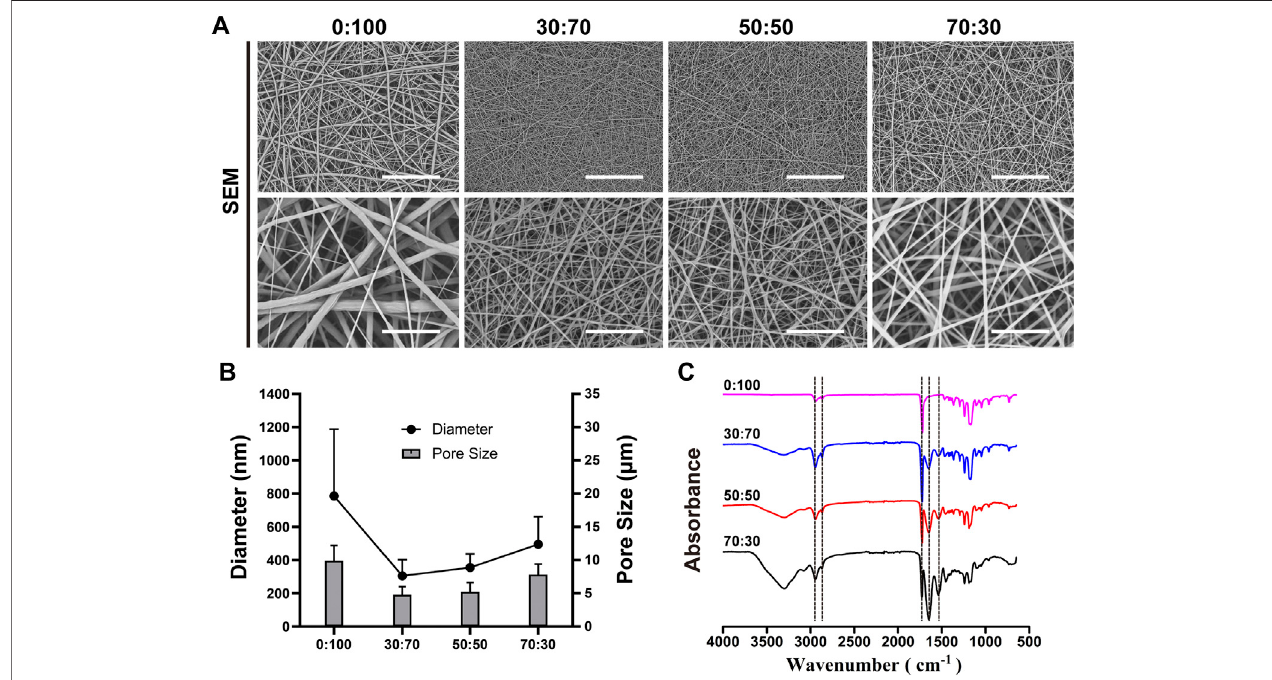
FIGURE 1 | Representative (A) SEM micrographs [scale bars equal 50 μ m (low magni fi cation) and 10 μ m (high magni fi cation)], (B) fi ber diameters and pore sizes, and (C) FT-IR spectra of nano fi brous membranes.